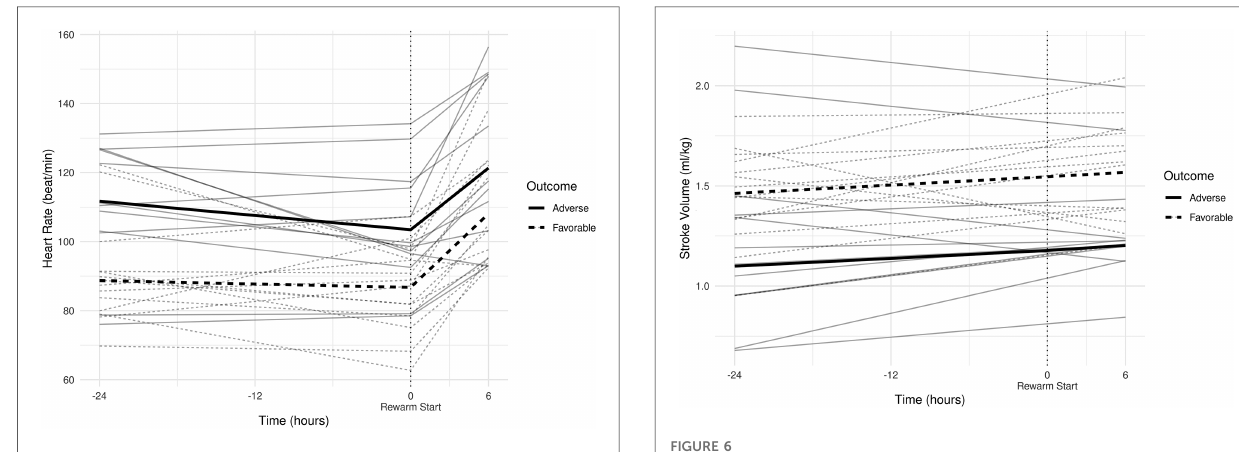
FIGURE 4 Estimated individual heart rate regression lines and group-level averages of graphs.